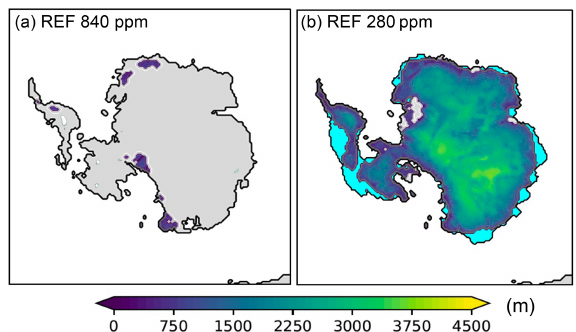
Figure 2. (a) Simulated equilibrated grounded ice thickness from experiment REF with 840ppm and (b) 280ppm CO 2 forcing, start- ing without ice. Cyan areas indicate ice shelf extent and grey areas ice-free